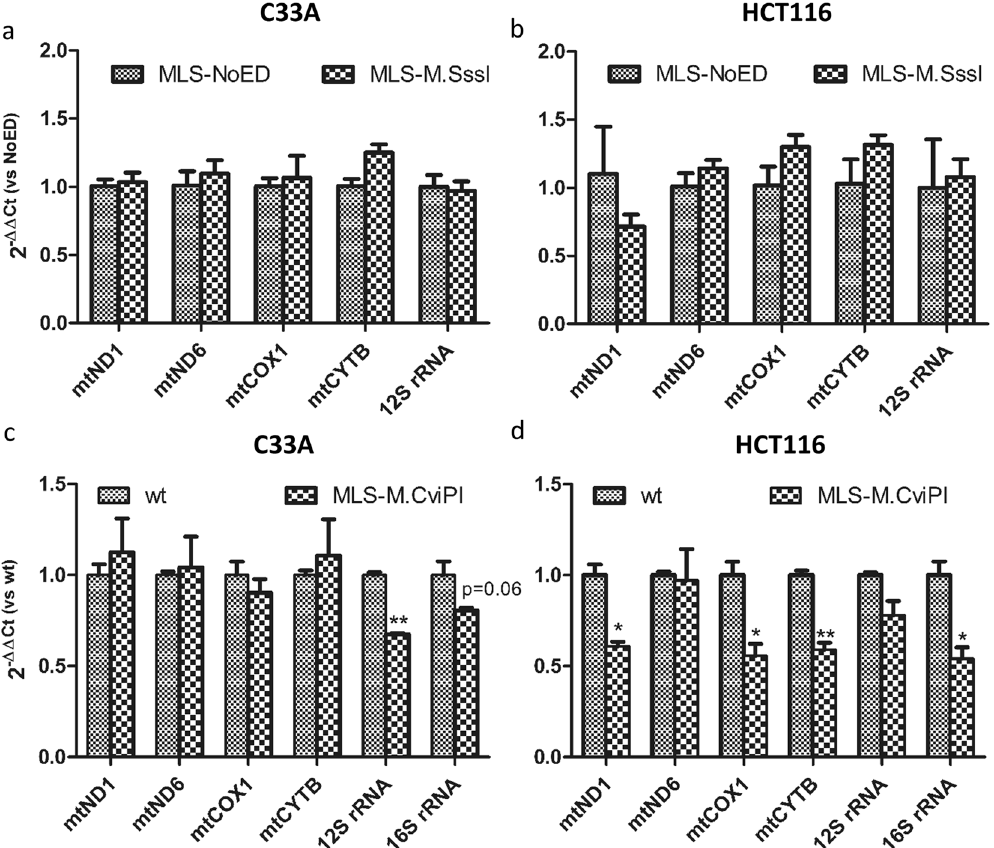
Figure 5. Normalised mitochondrial gene expression in cells expressing mitochondria-targeted M.SssI or M.CviPI. Expression of five ( a , b ) or six ( c , d ) mitochondrial genes ( mtND1 , mtND6 , mtCOX1 , mtCYTB , 12S rRNA and 16S rRNA ) was determined in stable cell lines of C33A ( a ) or HCT116 ( b ) cells expressing mitochondria-targeted M.SssI (MLS-M.SssI) or empty vector control (MLS-NoED), and C33A ( c ) or HCT116 ( d ) cells expressing mitochondria-targeted M.CviPI (MLS-M.CviPI) or wild-type cells (wt). Each bar shows the mean ± SEM of three independent